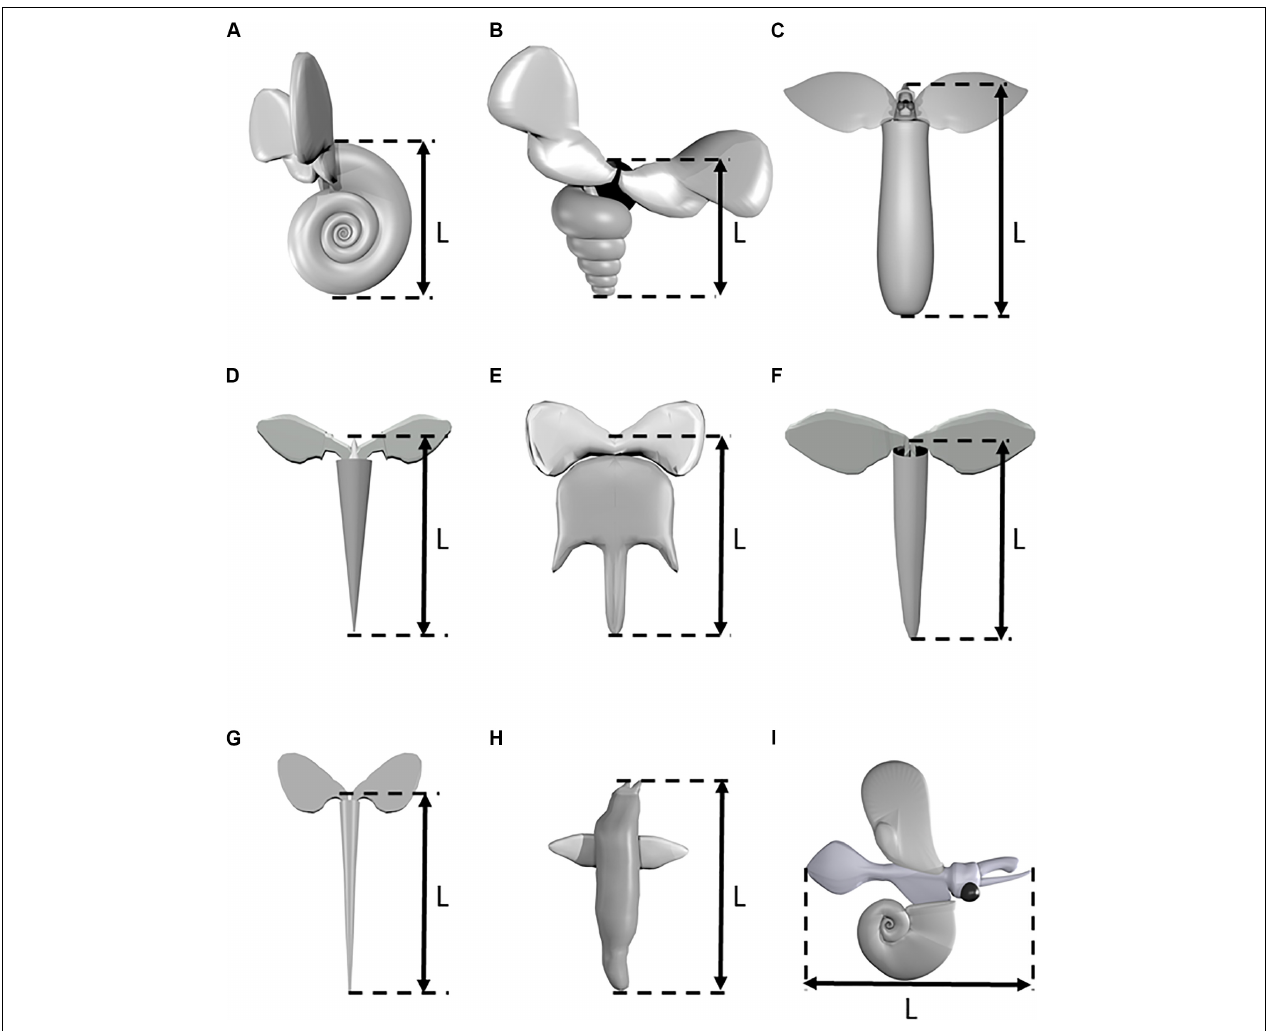
FIGURE 2 | Three-dimensional models of various marine snail species. (A) Heliconoides inflatus, (B) Limacina bulimoides, (C) Cuvierina atlantica, (D) Hyalocylis striata, (E) Diacria trispinosa, (F) Styliola subula, (G) Creseis clava, (H) Pneumoderma atlantica, (I) Heteropod sp. Models are not drawn to scale.